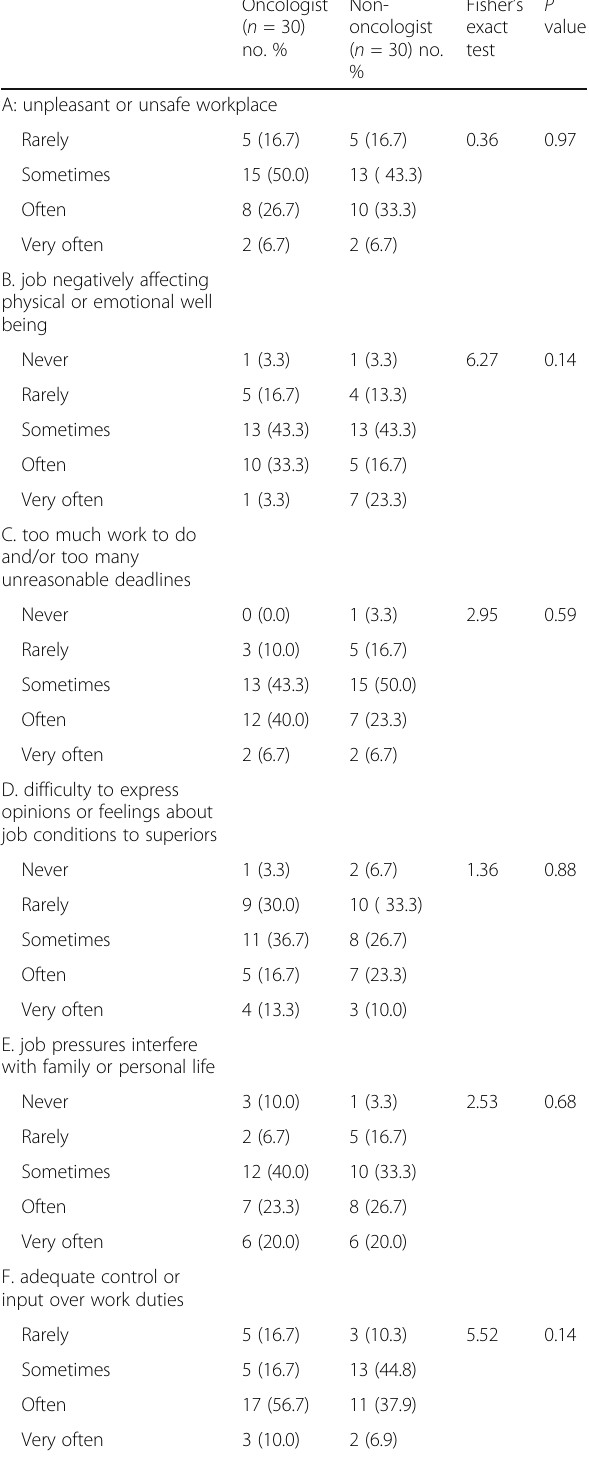
Table 5 Comparison between oncologist and non-oncologist regarding different items of work place stress scale